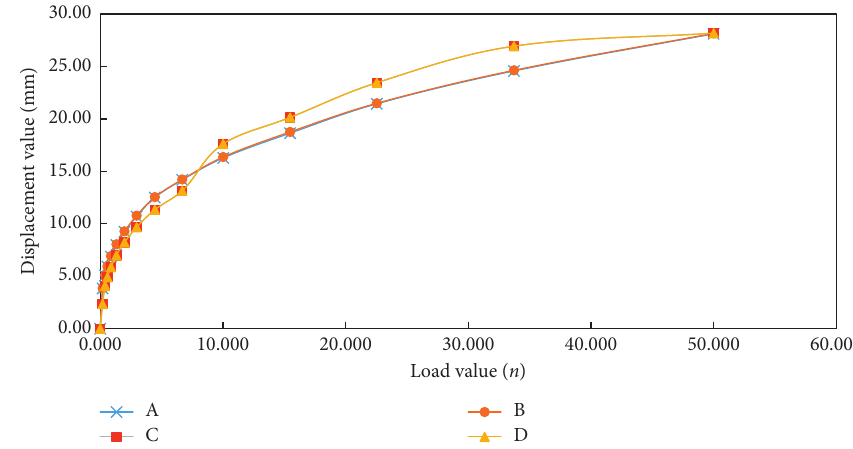
Figure 7: Displacement curves of beam element and bar element with and without deleted nodes.